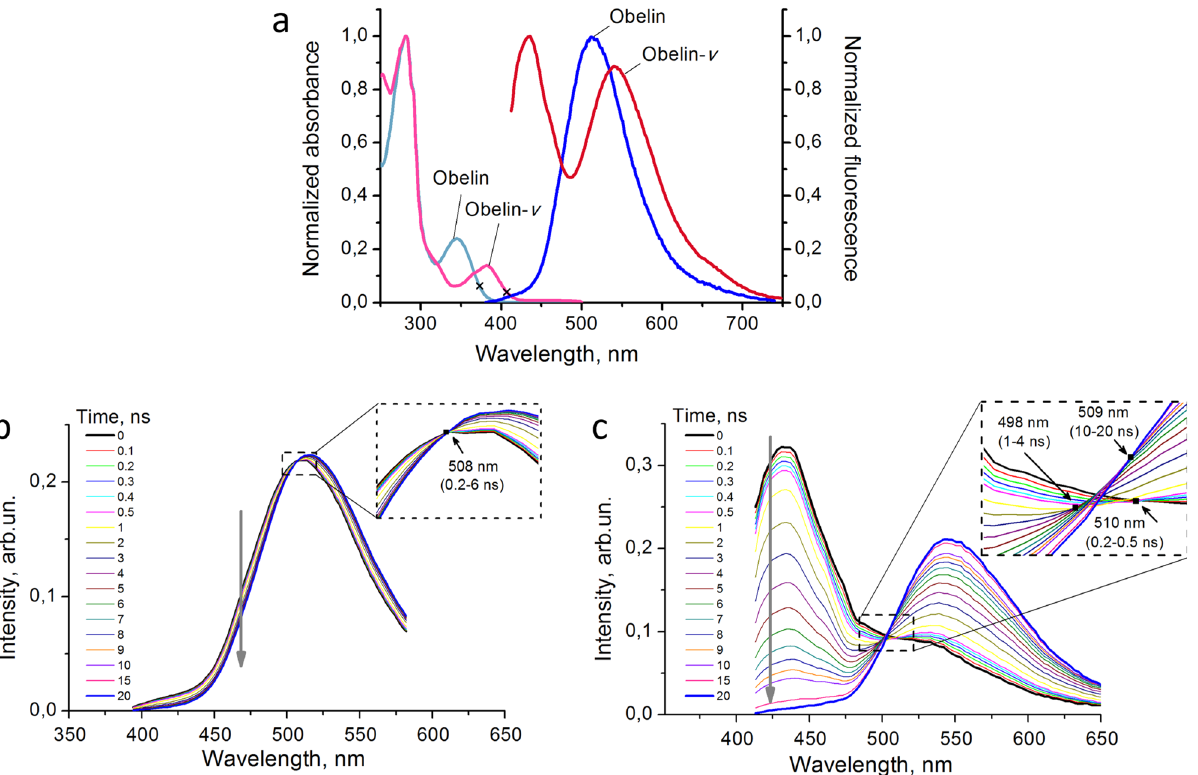
Figure 5. Fluorescence properties of Ca 2+ -discharged obelin and obelin- v . ( a ) Absorption (left) and fluorescence (right) spectra of Ca 2+ -discharged obelin (cyan and blue colors) and obelin- v (pink and red colors). Spectra are normalized to the maximum. Fluorescence excitation wavelength was 373 nm for obelin and 407 nm for obelin- v (shown as crosses on the spectra). ( b ) TRANES of Ca 2+ -discharged obelin, excitation at 373 nm and ( c ) Ca 2+ -discharged obelin- v , excitation at 407 nm. Inserts show the area of isoemissive points which are indicated with markers. Gray arrows show a direction of the bands change in